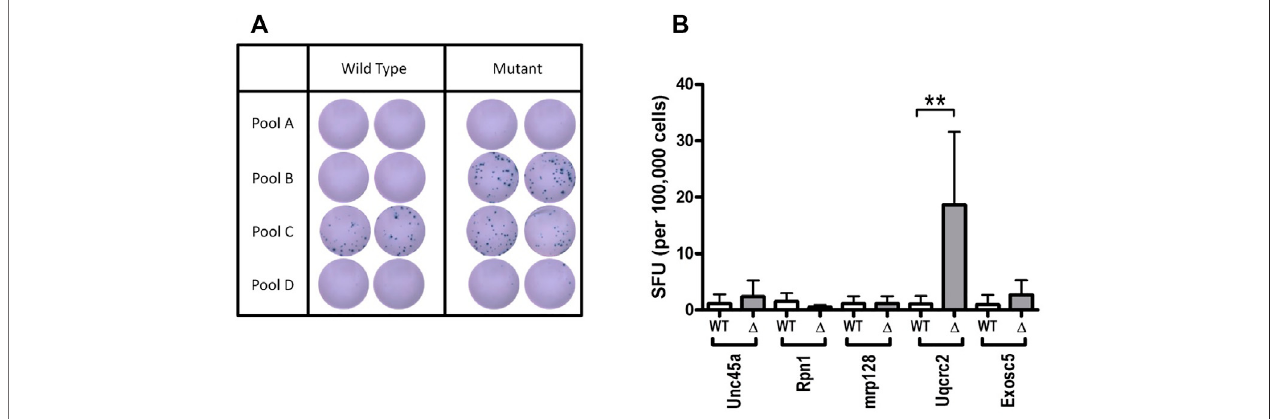
FIGURE 5 | Immune responses to candidate asbestos-induced neo-antigens in murine mesothelioma. Immune responses against a panel of neo-antigen candidates predicted from genome sequencing (A) Representative duplicate wells from interferon- γ ELISPOT analysis of total tumour draining lymph node cell preparations from non-treated AB1 tumor-bearing mice against pools of predicted neo-antigenic peptides (B) Summary of ELISPOT data showing mean ± SD for the deconvolution of peptide Pool B. Mutant ( Δ ) peptide; wildtype (WT) peptide for indicated genes harboring single nucleotide variants. Figure originally published in Creaney et al., 2015. Oncoimmunology 4: